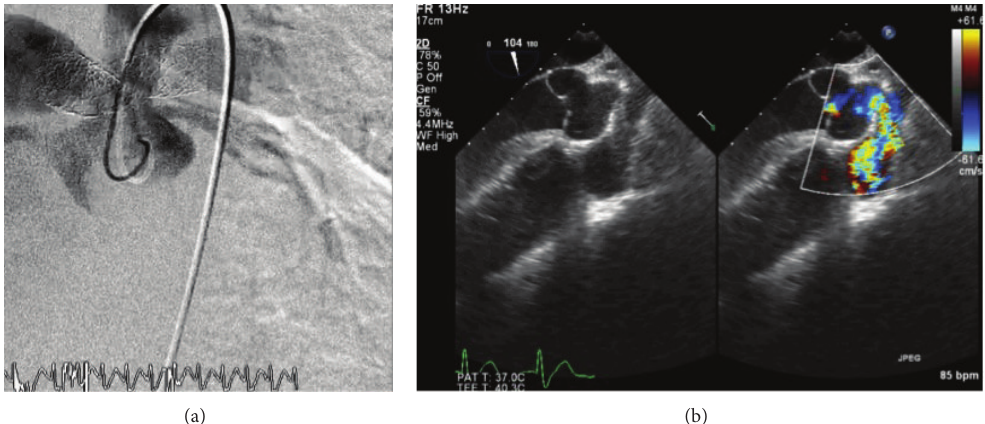
Figure 1: Angiogram with contrast injection in the ascending aorta showing simultaneous opacification of the RPA (a); mid oesophageal long axis showing a communication between the ascending aorta and the RPA (b).